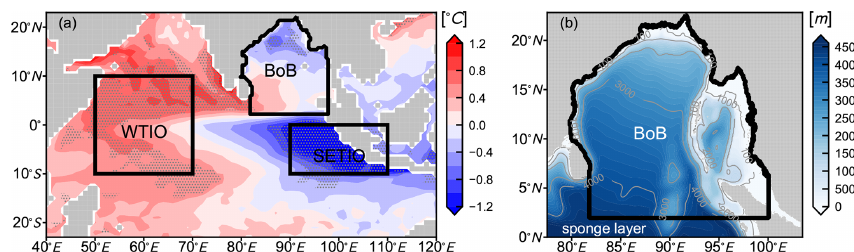
Figure 1. Composite of sea surface temperature anomalies during ASO of pIOD years from MPI-ESM-MR (a) . The contour intervals are 0.2 ◦ C. Anomalies significant at the 95% confidence level using a two-tailed Welch’s t test are hatched with grey dots. The western tropical Indian Ocean (WTIO) and southeastern tropical Indian Ocean (SETIO), the two areas related to the dipole mode index (DMI), are marked with black boxes. The bathymetry used in the downscaling simulation is shown in (b) . Our research domain, the Bay of Bengal (BoB), is marked with black borders in (a) and (b)